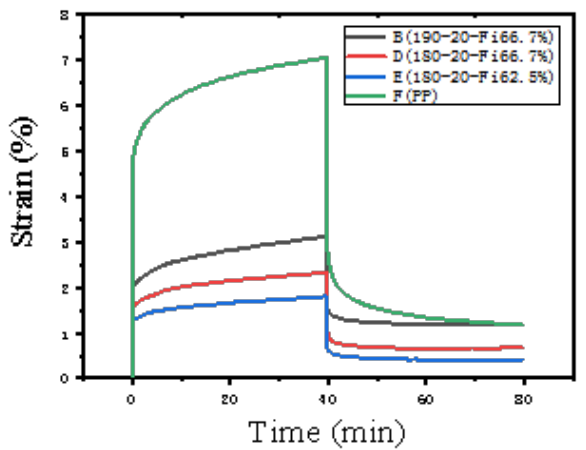
Figure 4. Creep curve of composite material and polypropylene: (B) the hot-pressing temperature was 190 ◦ C, the hot-pressing time was 20 min, and the paper content was 66.7%; (D) the hot-pressing temperature was 180 ◦ C, the hot-pressing time was 20 min, and the paper content was 66.7%; (E) the hot-pressing temperature was 180 ◦ C, the hot-pressing time was 20 min, and the paper content was 62.5%; (F) the hot-pressing temperature is 180 ◦ C and the hot-pressing time is 20